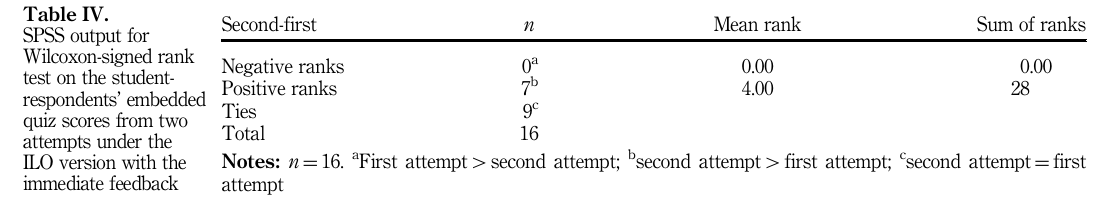
Table V. SPSS output for Wilcoxon-signed rank test on the student- respondents ’ embedded scores from two attempts under the ILO version with the delayed